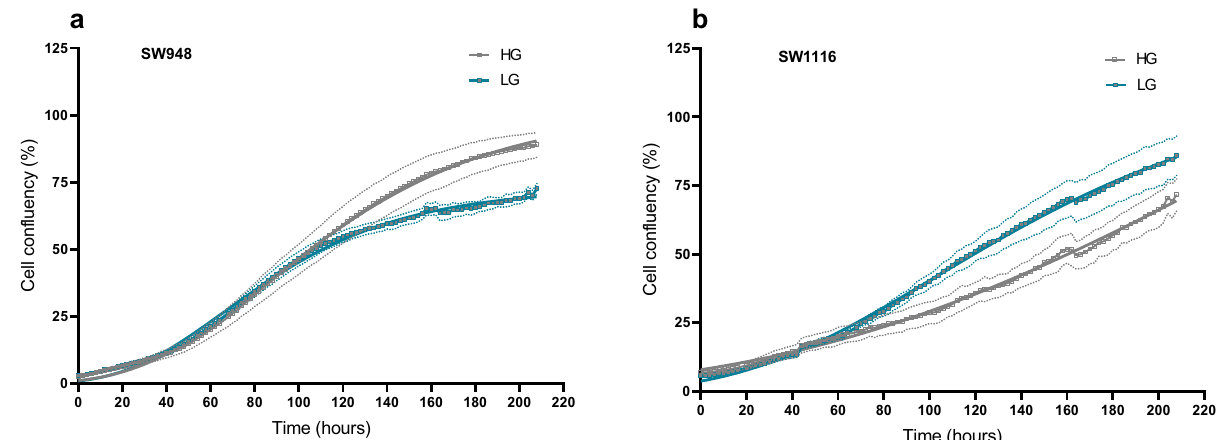
Figure 1. Cell growth recording of SW948 and SW1116 in HG and LG over 9 days continuous monitoring using Incucyte ZOOM. Cell confluency was analyzed in the Incucyte ZOOM software and plotted here as confluency (%) over time (hours). ( a ) SW948, initial seeding density of 10,000 cells/well. ( b ) SW1116, initial seeding density of 20,000 cells/well. Complete growth medium was exchanged at day 2 and 7 of the culture period. Grey solid line depicts growth in high glucose (HG) conditions, whereas blue solid line represents growth in low glucose conditions (LG). The dotted lines represent standard deviation from the average of N = 8 for each